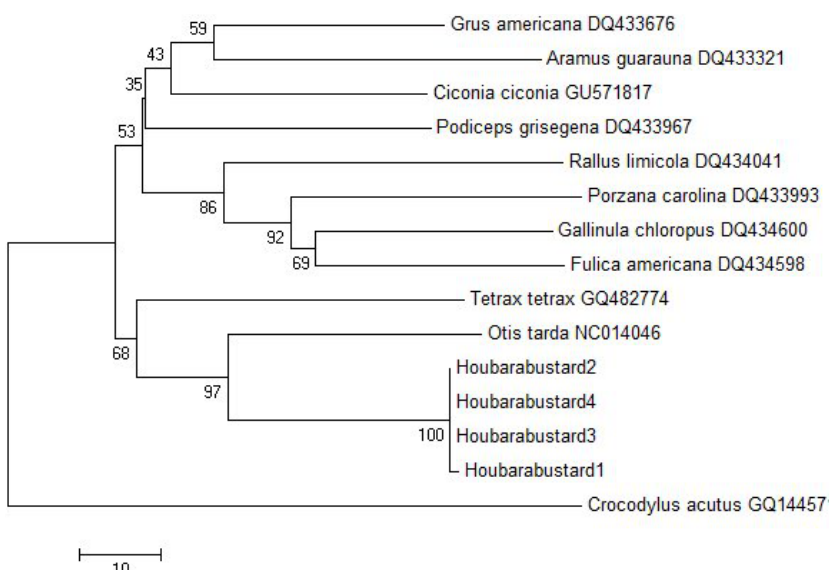
Figure 3. NJ tree showing the relationship among 15 different species including the out group, Crocodylus acutus .